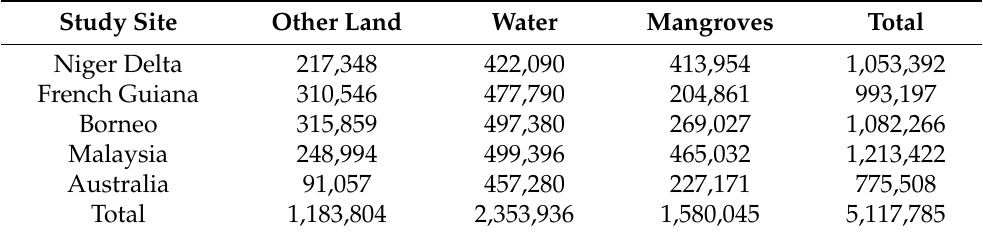
Table 2. Number of training samples used for each site, for each class. A total of 500,000 random samples were taken for each class, before only the stable models for the training year (2010) were screened out and used to train the